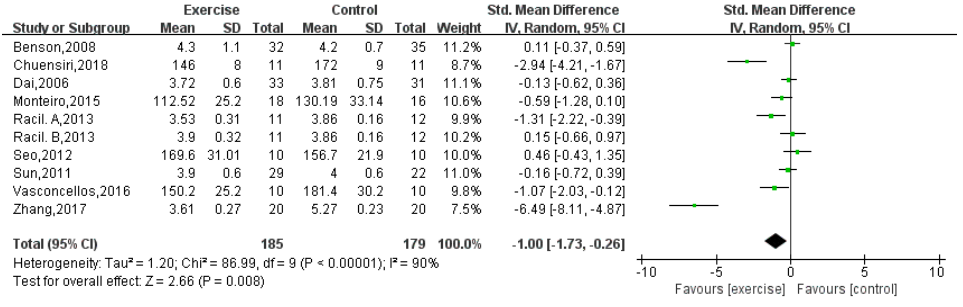
Figure 7. Forest plot of TC.